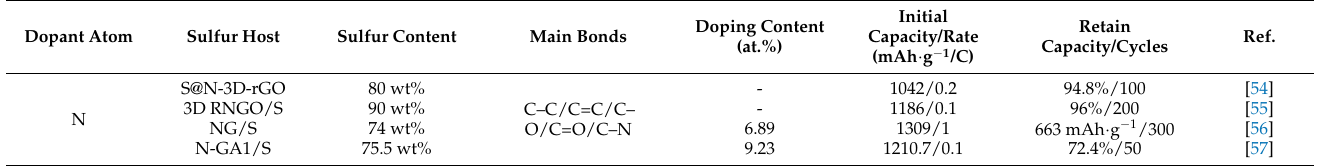
Table 1. Electrochemical performance of atom-modified graphene-based sulfur